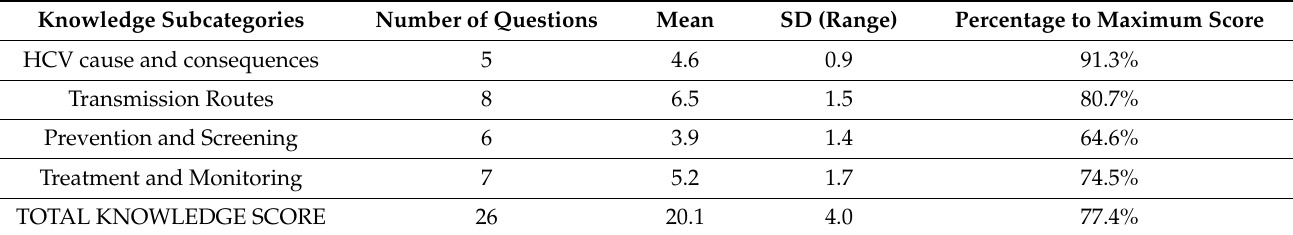
Table 2. Mean knowledge scores (n = 2000).